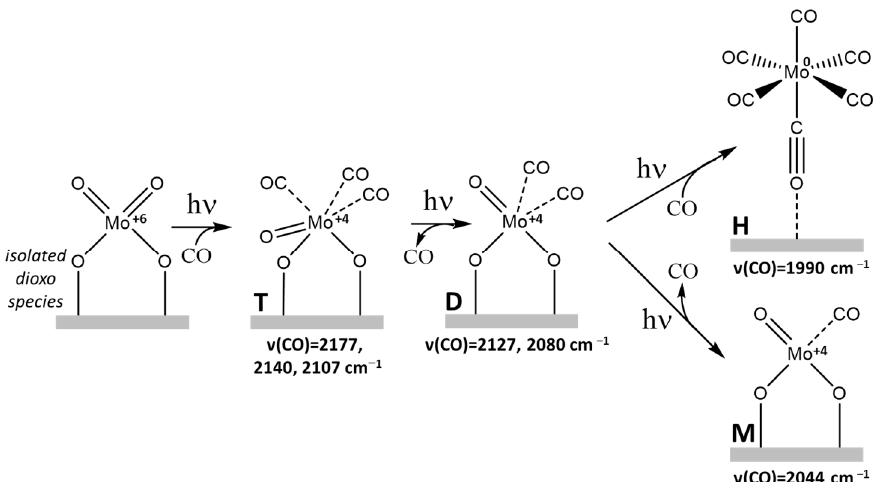
Figure 1. Proposed photoreduction pathways of silica-supported Mo in CO at room temperature. T, D, M and H indicate tricarbonyl, dicarbonyl, monocarbonyl and hexacarbonyl species, respectively. The vibrational frequencies associated with the different Mo-CO surface complexes are also reported.